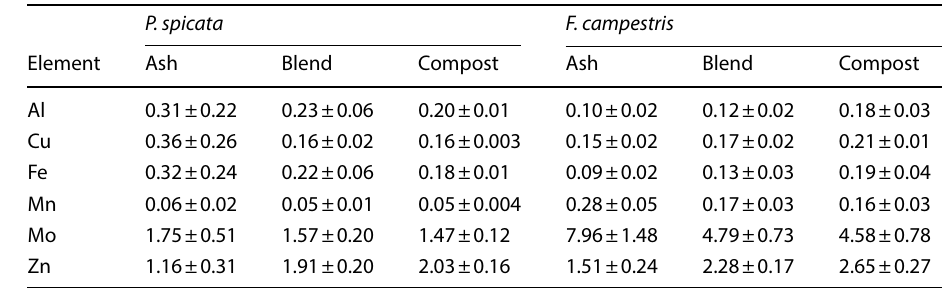
Values are means ± standard error of the mean ( n =